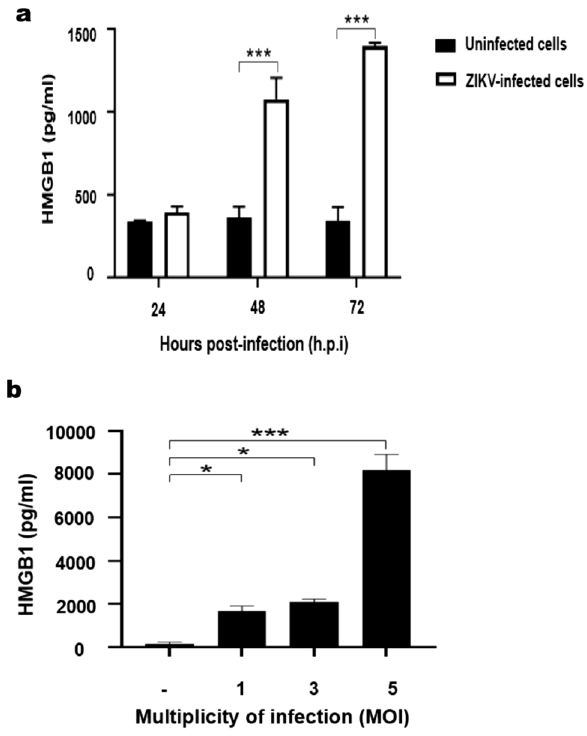
Figure 3. Extracellular HMGB1 levels during ZIKV infection: ( a ) Huh7 cells were mock-infected or infected with ZIKV at an MOI of 1. Supernatants of cell culture were harvested at 24-, 48- and 72-h post-infection (h.p.i) and the level of HMGB1 was measured by ELISA. Asterisks (**) indicate a significant difference (P < 0.01). ( b ) Huh7 cells were mock-infected or infected with ZIKV at an MOI of 1, 3 and 5. Supernatants were then harvested at 72 h.p.i for extracellular HMGB1 detection by ELISA. Statistical differences between the groups were indicated: *P < 0.05, **P < 0.01, ***P < 0.001.